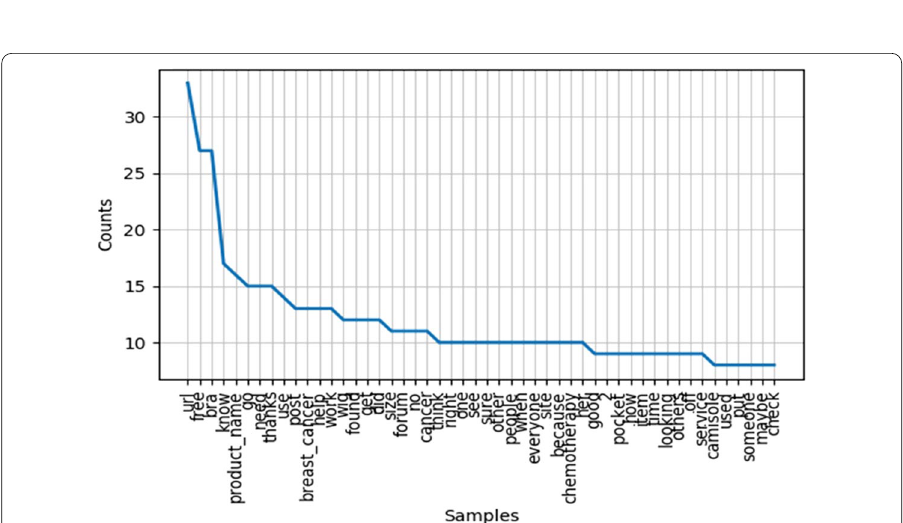
Fig. 4 Top 50 tokens after normalizing and cleaning